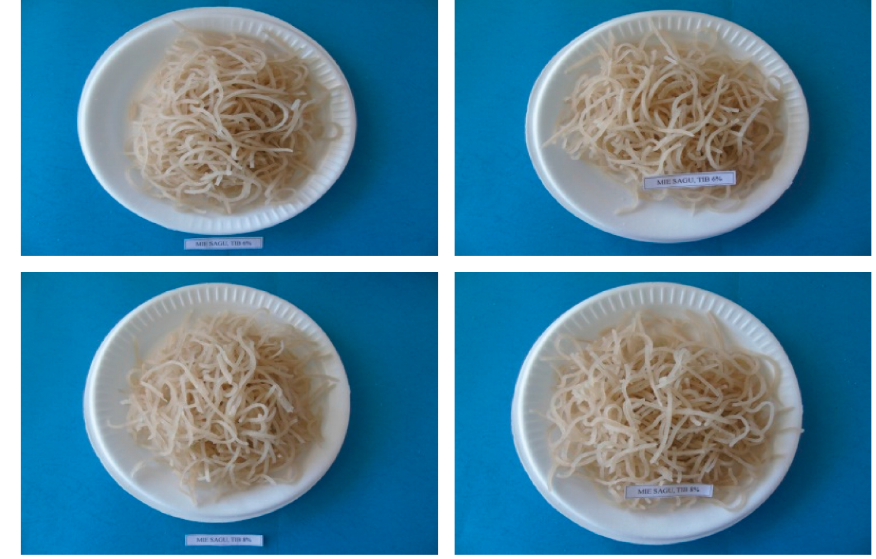
Figure 1: Photograph sago noodles (M